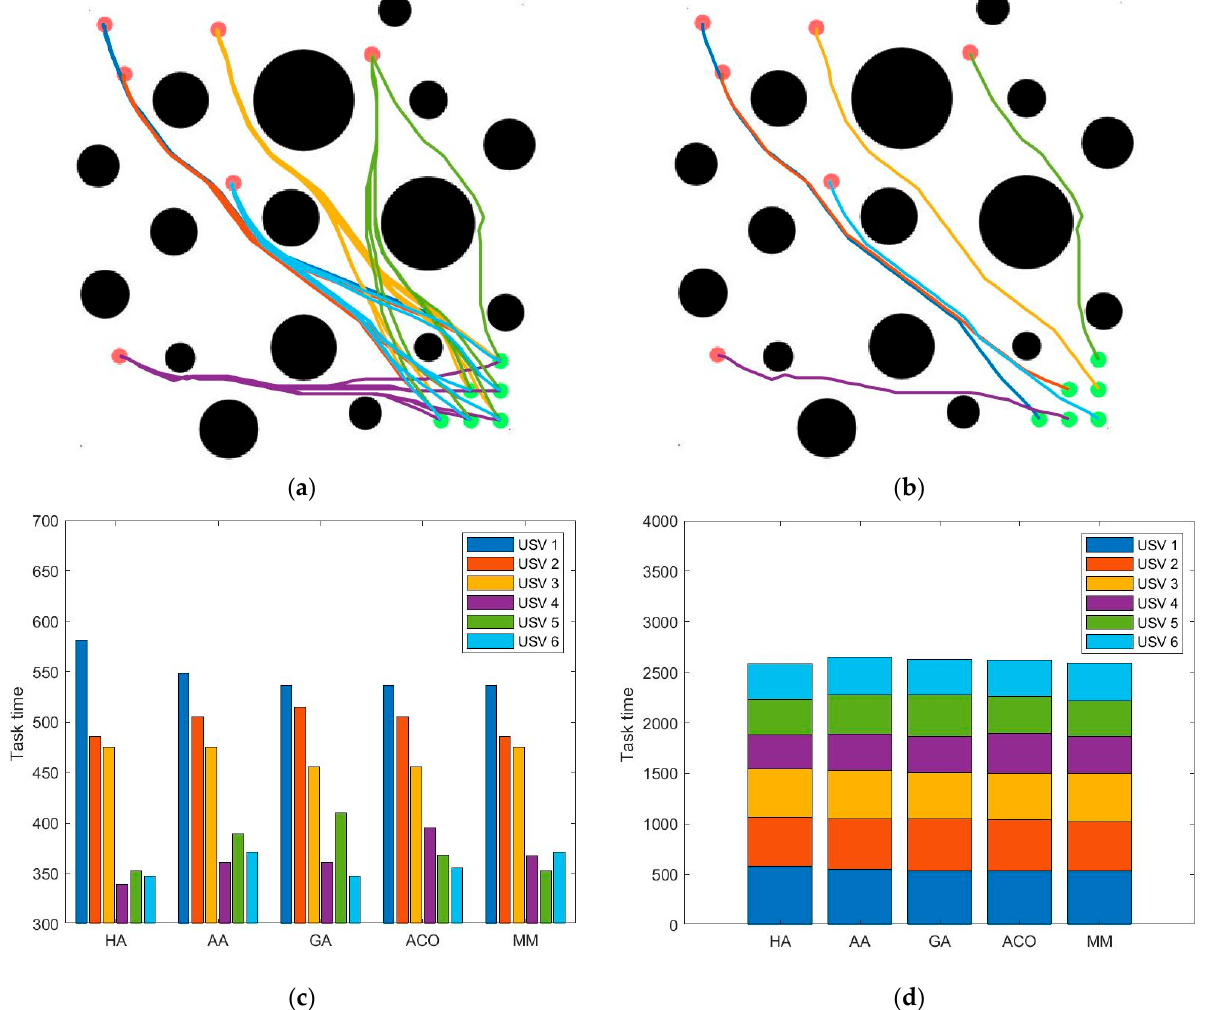
Figure 3. Path planning in task allocation, and the results of algorithms. ( a ) The planned paths from each USV to each target point. ( b ) The selected paths of the proposed algorithm MM. ( c ) The task time of each USVs in the results of algorithms. ( d ) The total task time of each USVs in the results of